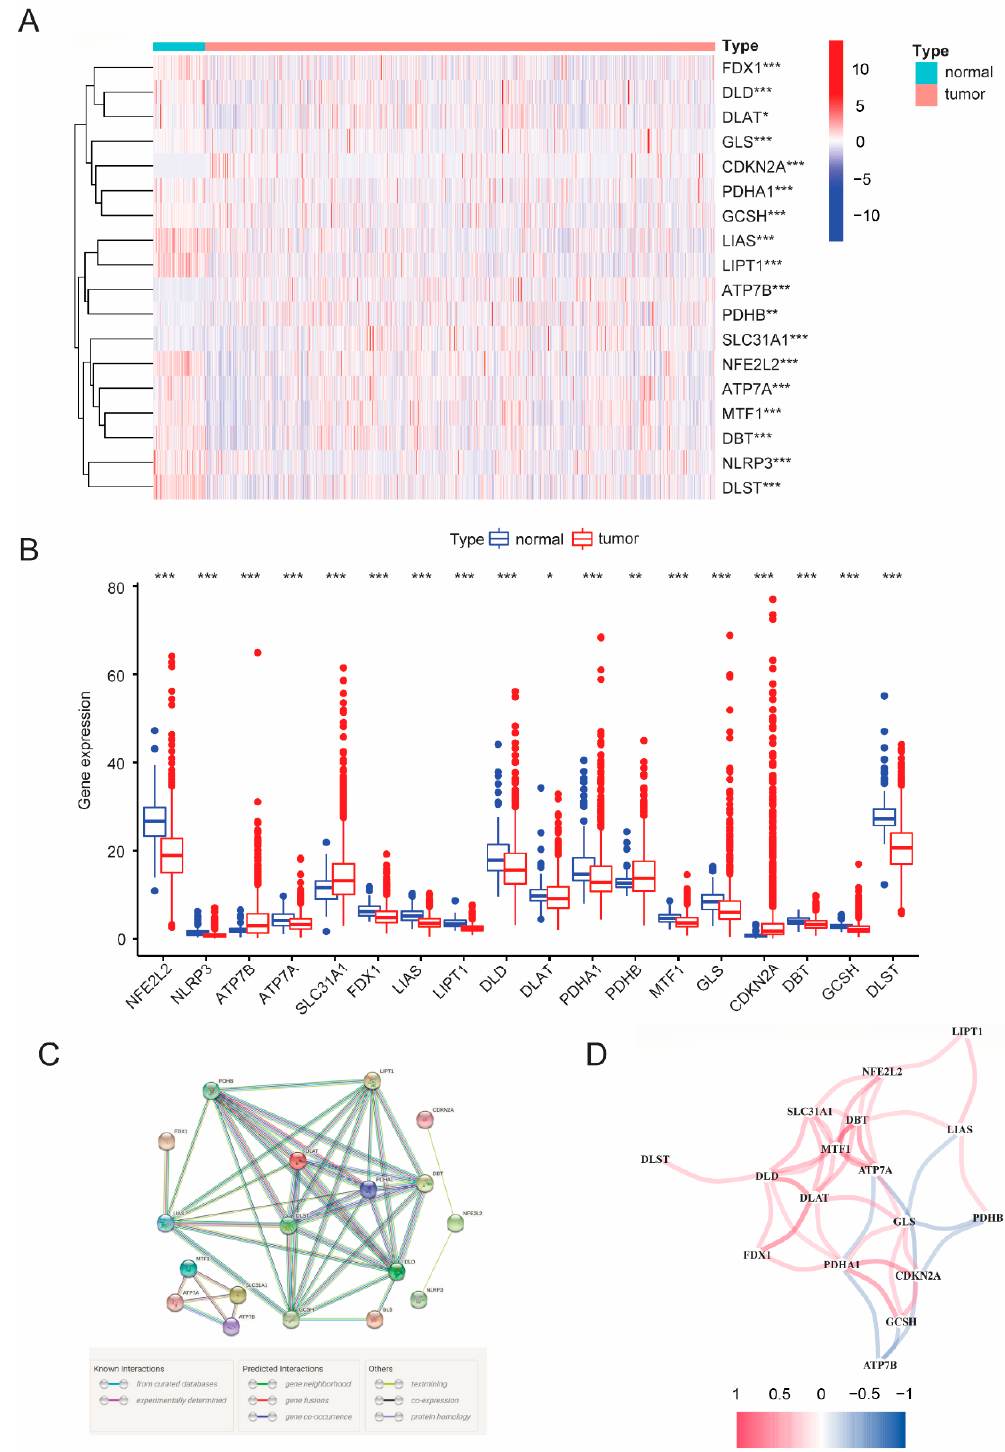
Figure 1. Expressions and interaction relationship of the 19 CRGs between breast para-carcinoma tissues and tumor tissues. ( A ) Heatmap of the CRGs between the para-tumor and the tumor tissues (red: high expression gene, blue: low expression gene). The p values were set as: * p < 0.05; ** p < 0.01; *** p < 0.001. ( B ) Bar diagram of the comparison between para-tumor and tumor tissues regarding expression of 19 CRGs. ( C ) PPI network of the CRGs. ( D ) The correlation network of the 19 CRGs (red: positive correlation; blue: negative correlation; color depth represents correlation strength).